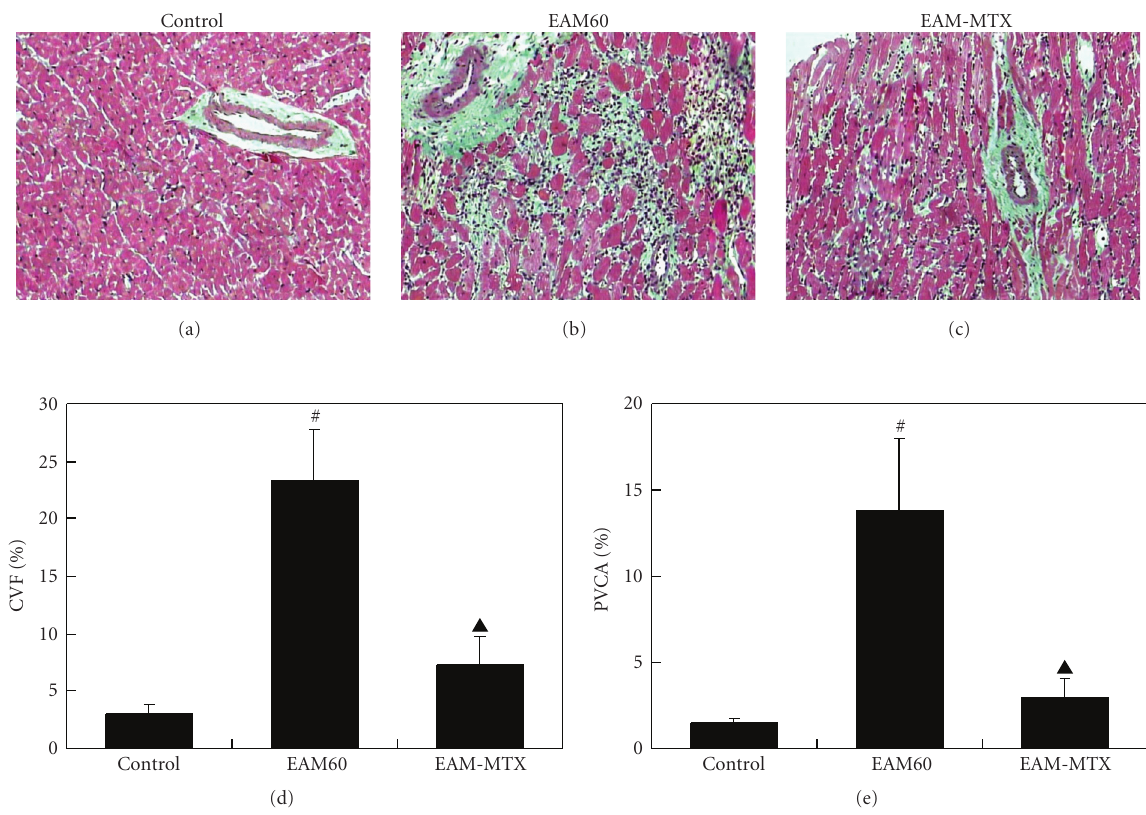
Figure 3: Masson’s trichrome staining. Representative photomicrographs of the ventricular sections from the three groups of rats are shown ( × 200). Green staining represents the collagen fibers (a)–(c). Myocardial collagen volume fraction (CVF; (d)) and perivascular collagen area (PVCA; (e)) were calculated in the control, EAM60 and EAM-MTX groups, respectively. All results are represented as mean ± SD ( n = 10). ∗ P < . 05, # P < . 01 versus control group; (cid:2) P < . 01 versus EAM60